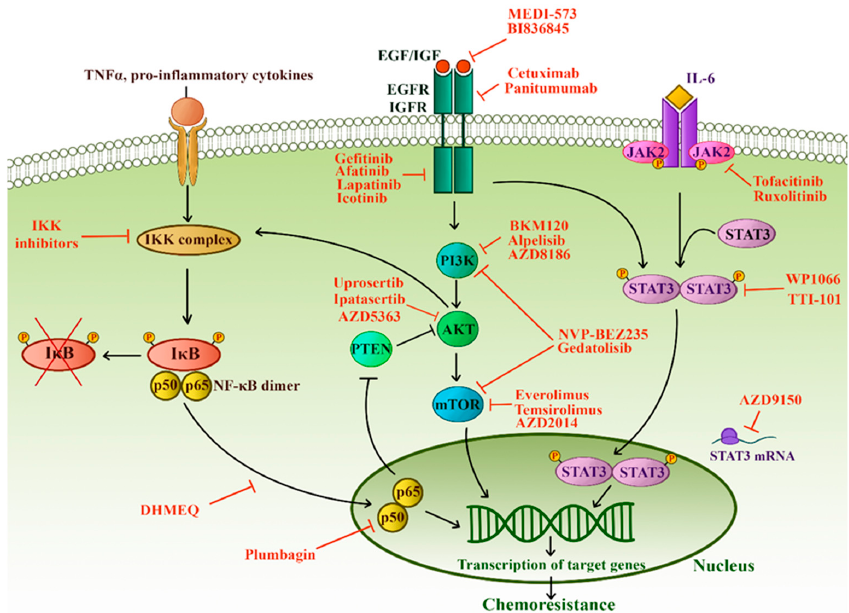
Figure 5. Targeting the nuclear factor kappa-light-chain-enhancer of activated B cells (NF- κ B); PI3K- Figure5. Targetingthenuclearfactorkappa-light-chain-enhancerofactivatedBcells(NF- κ B);PI3K-AKT- AKT-mTOR (PAM); Janus kinase (JAK)/signal transducer and activator of transcription (STAT) mTOR (PAM); Janus kinase (JAK) / signal transducer and activator of transcription (STAT) pathways pathways and receptor tyrosine kinases in TNBC. Select inhibitors are shown in red. and receptor tyrosine kinases in TNBC. Select inhibitors are shown in